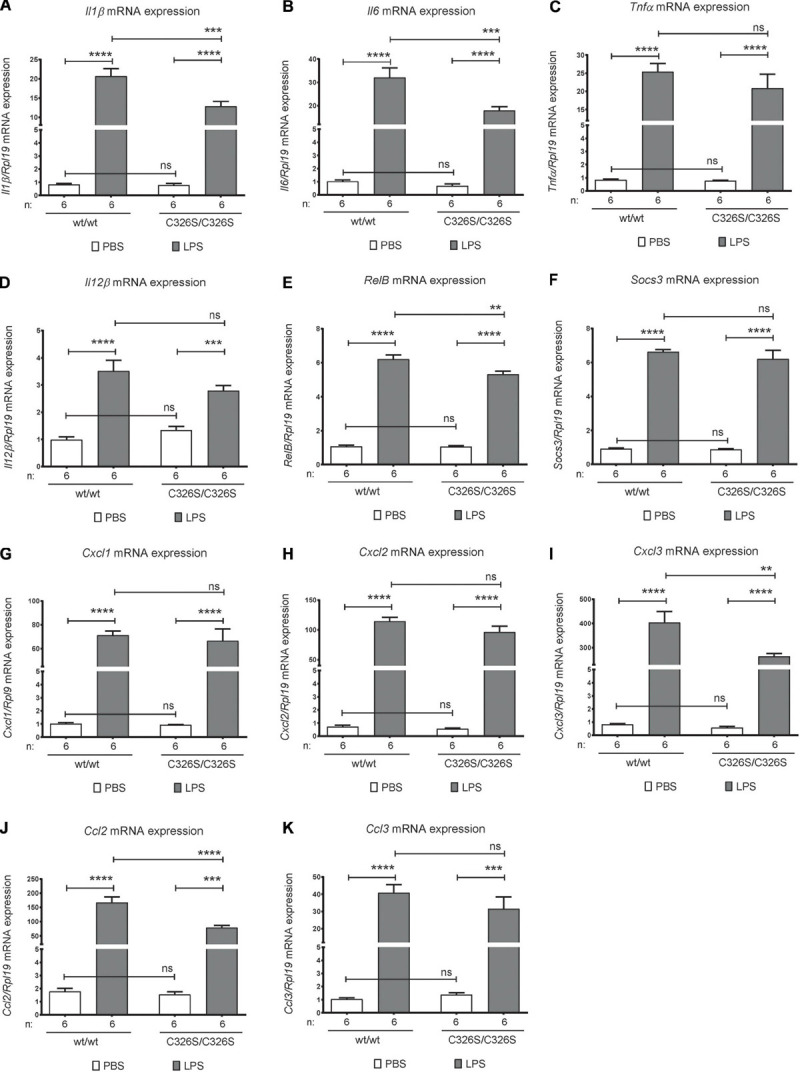
Pulmonary inflammatory response upon LPS inhalation. qRT-PCR analysis of Il1β (A), Il6
(B), Tnfα (C), IL12β (D), RelB
(E), Socs3
(F), Cxcl1
(G), Cxcl2
(H), Cxcl3
(I), Ccl2
(J), and Ccl3
(K) in the total lung of 14-week old female wild-type (wt/wt) and Slc40a1C326S/C326S (C326S/C326S) mice upon PBS or LPS nebulization. Number of mice analyzed (n) is indicated in each graph. Data are reported as mean ± SEM. Two-way ANOVA: **p < 0.01; ***p < 0.001; ****p < 0.0001.